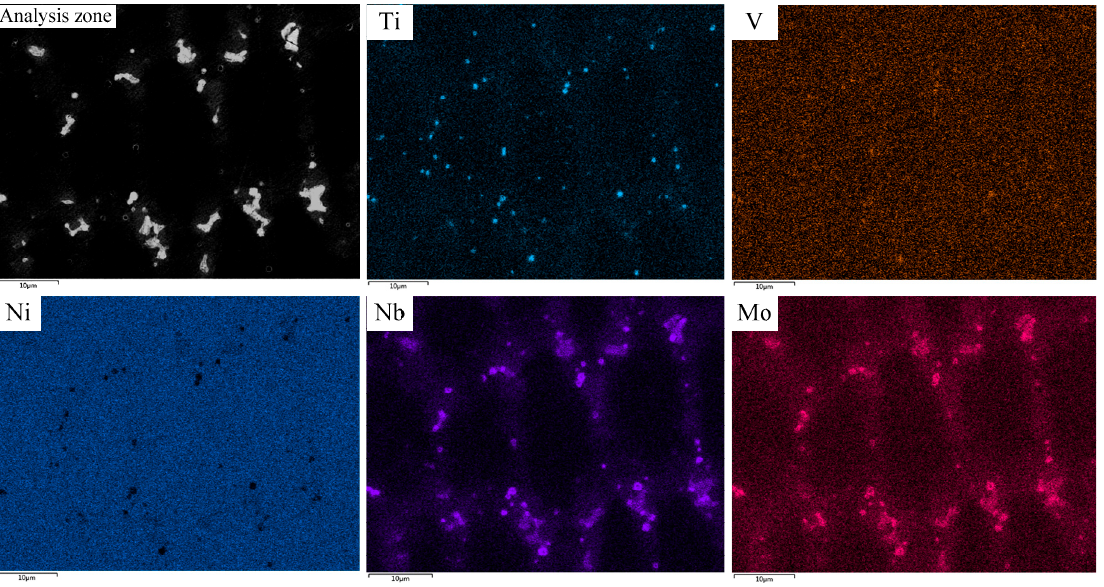
Figure 7. Elements distribution of No.2 alloy.